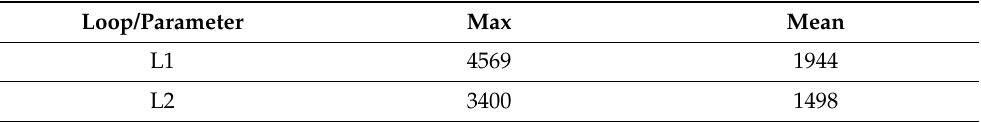
Table 16. Induction loop signal characteristics—amplitude and mean signal value